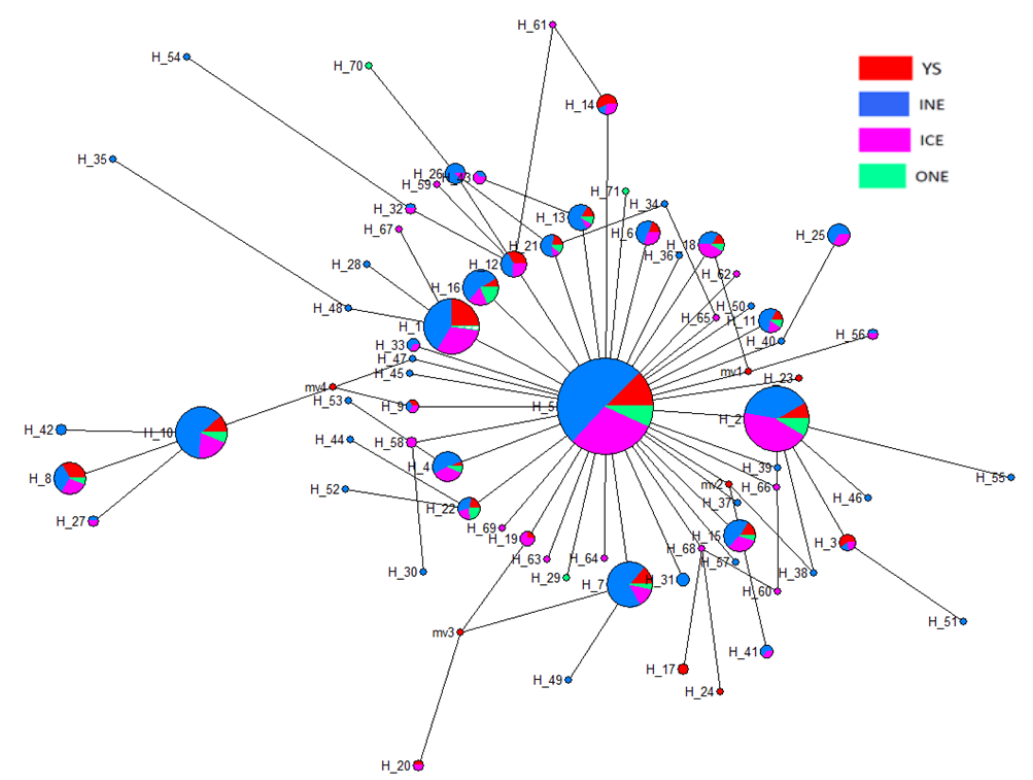
Figure 2. Haplotype network of the large yellow croaker based on the mtDNA COI region (71 haplotypes). The dots between the nodes indicate the number of mutations. The area of each circle is proportional to the corresponding haplotypes.